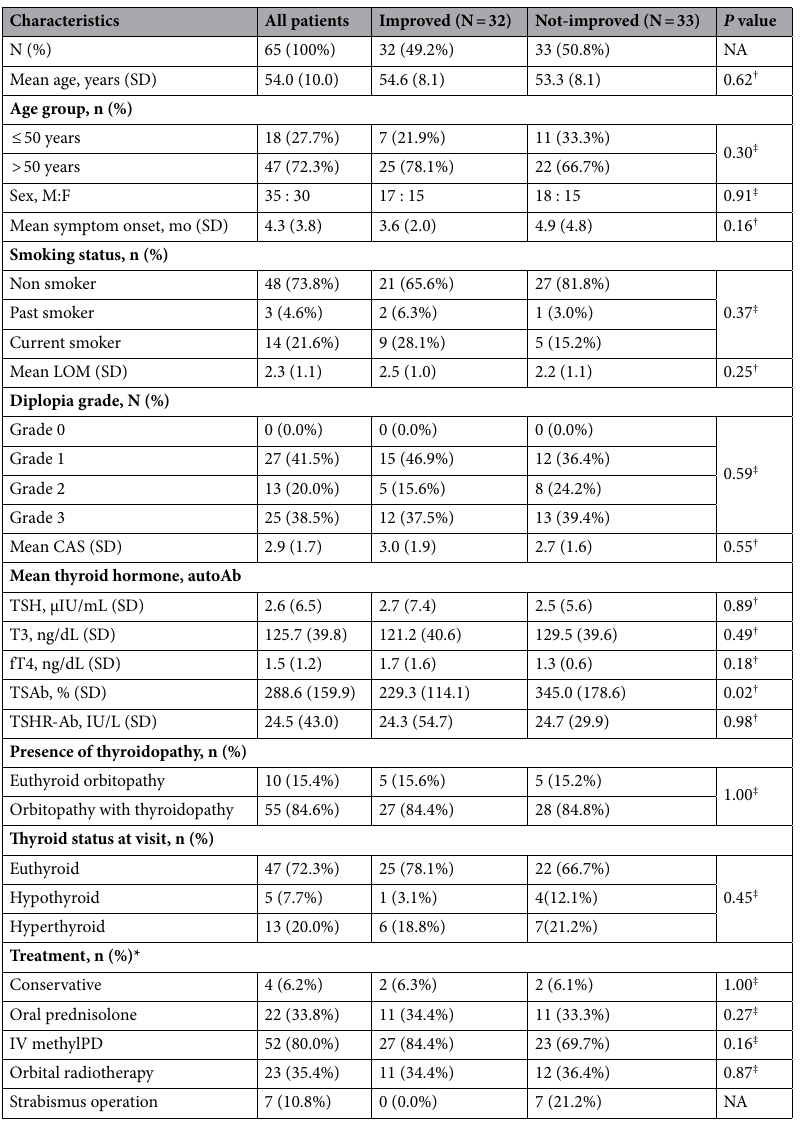
Table 1. Comparisons of demographic and clinical characteristics in the improved and not-improved groups at initial presentation. N number, SD standard deviation, Mo month, M male, F female, LOM limitation of muscle excursion, CAS clinical activity score, TSH thyroid stimulating hormone, T3 triiodothyronine, fT4 free thyroxine, TSAb thyroid-stimulating antibody, TSHR-Ab thyroid stimulating hormone receptor antibody, IV methylPD intravenous methylprednisolone, NA not available, † Student’s t test or Mann–Whitney test, ‡ Chi- square test or Fisher’s exact test. *If the patient underwent multiple treatment modalities, all modalities were